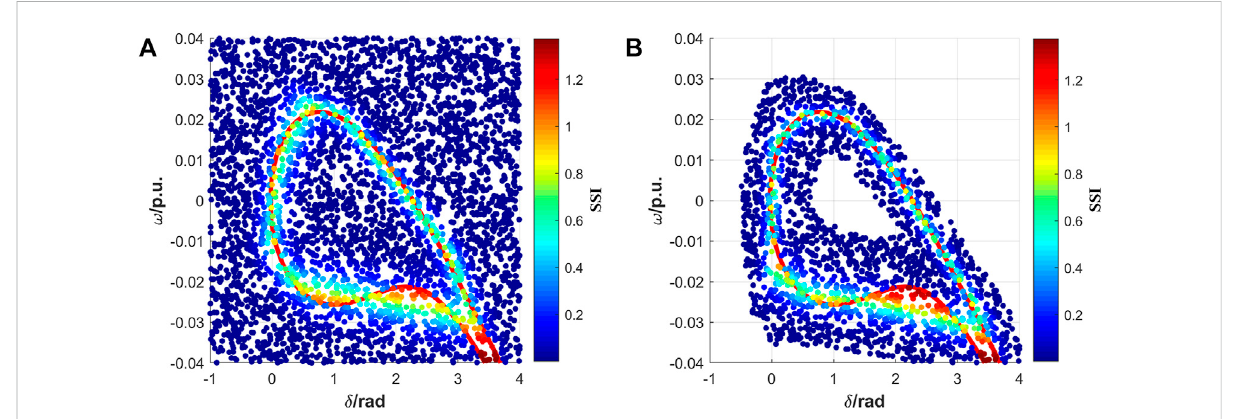
FIGURE 2 SSI at epoch 90 of the SMIB system. (A) shows the SSI of the full dataset and (B) shows the SSI of the subset after pruning.